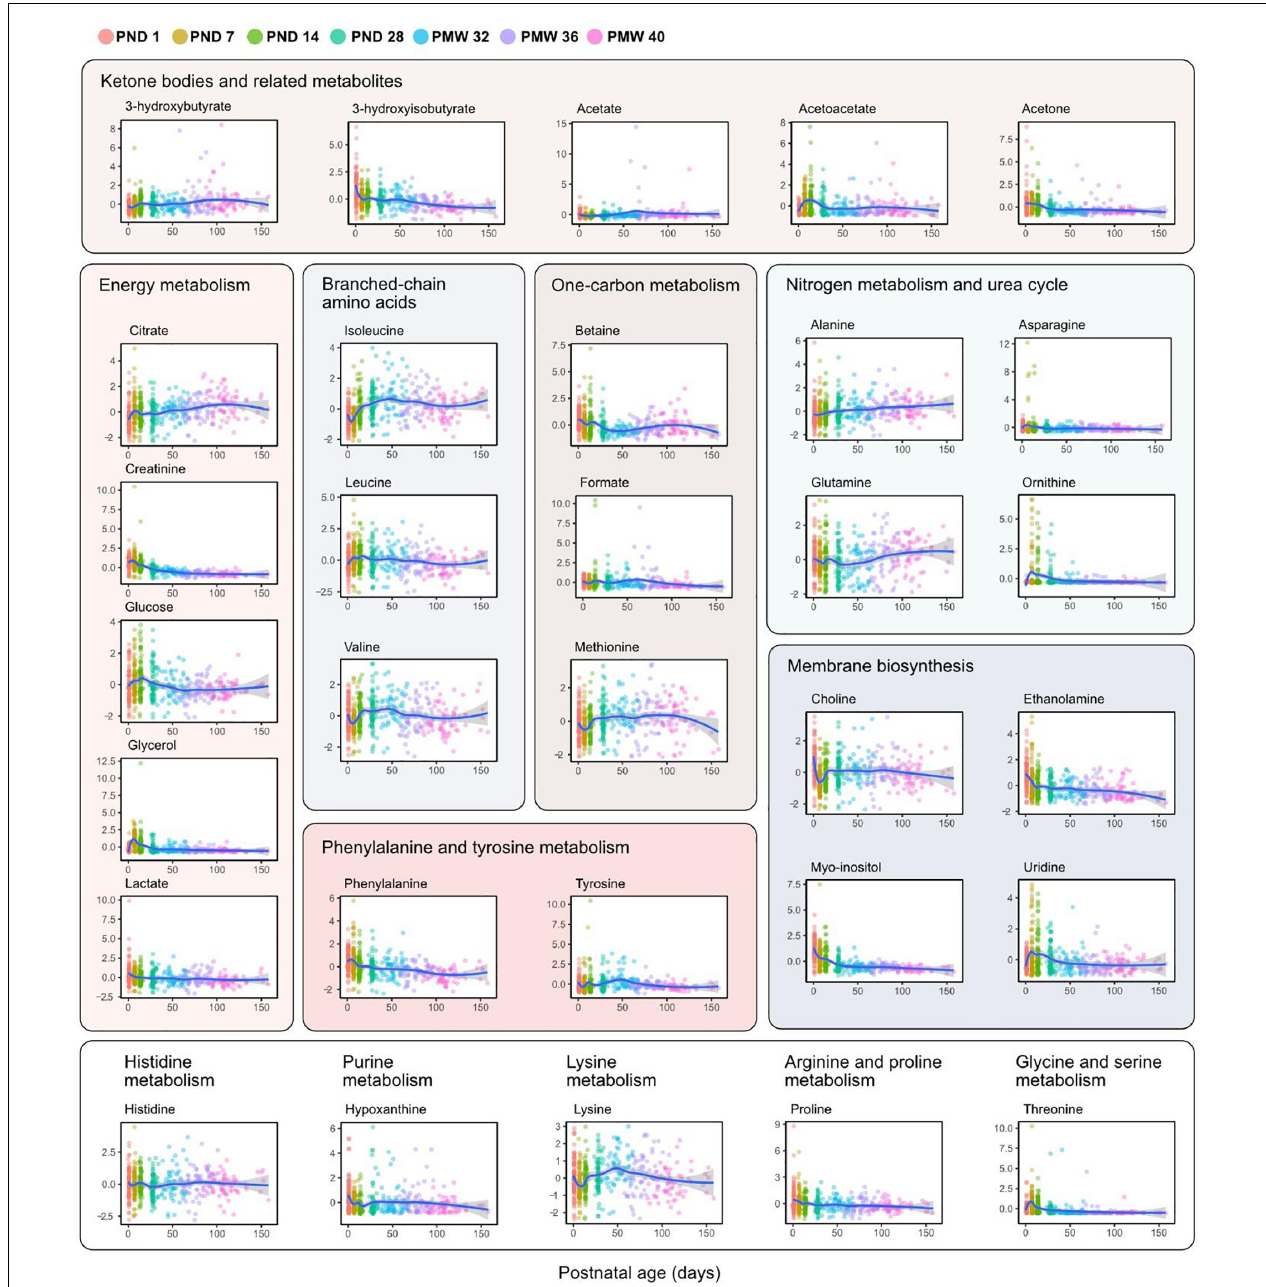
FIGURE 4 | Metabolite levels over postnatal age (days). Individual sample values are plotted and colored according to time point as indicated in the legend. Lines represent smoothed conditional means with 95% confidence intervals (shaded areas). Y -axis shows z-score normalized metabolite abundances.